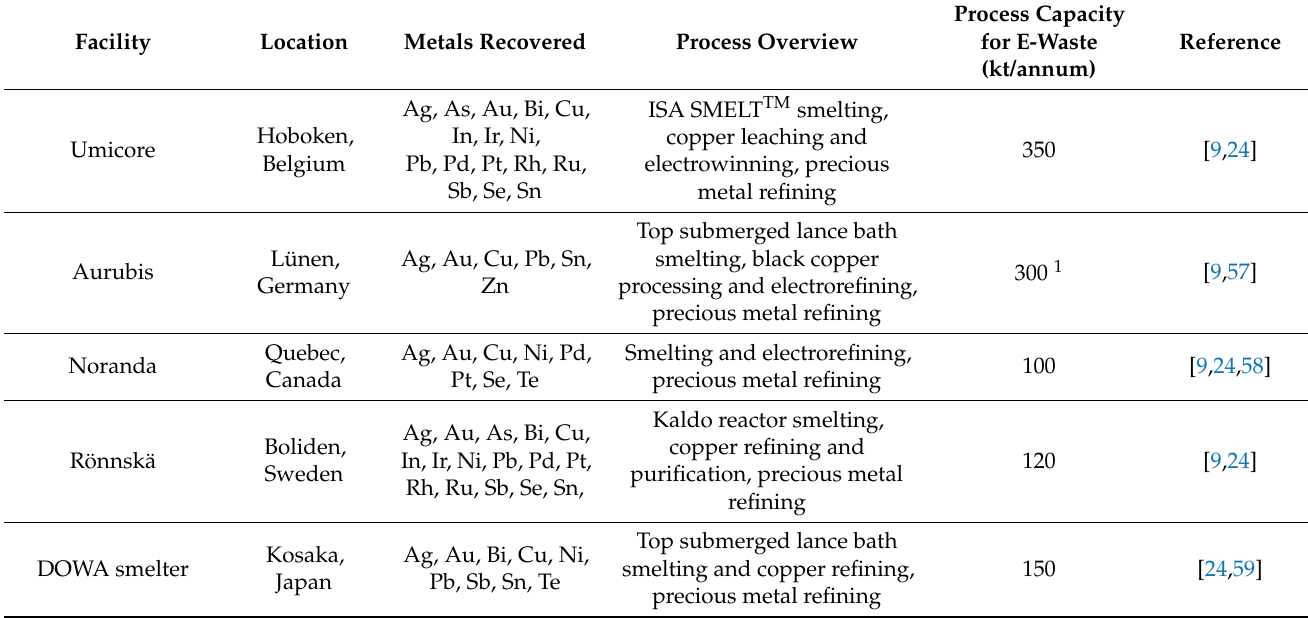
Table 3. Examples of some major pyrometallurgical facilities that extract metals from e-waste.